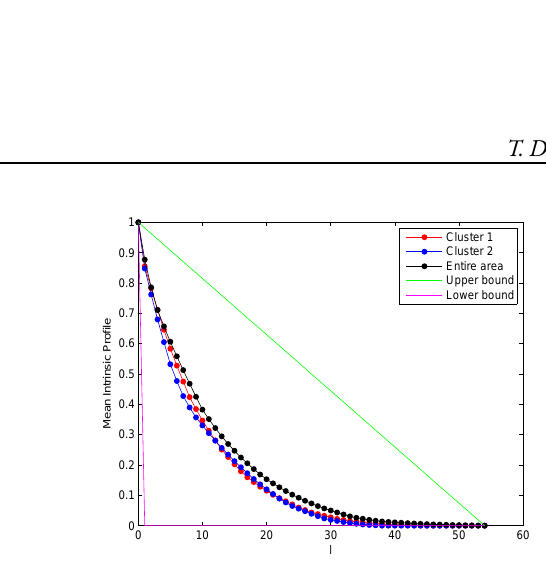
for cluster 1 (in red), cluster 2 (in blue) and for the entire area (in black). Figure 8 – Mean T l distinguish an ordering among the profiles since they continue to cross each